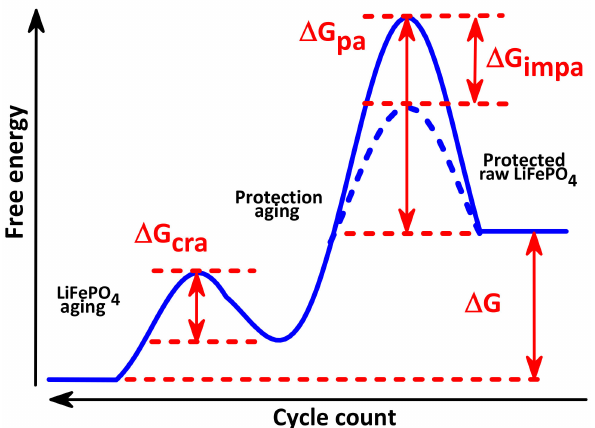
Figure 6. Scheme of two-stage LiFePO 4 cathode degradation. Here, the free energy in the metastable state is ∆ G at the battery operating temperatures. With an increased number of cycles, the protective ferric-graphite-graphene layer is destroyed with the corrosion activation energy ∆ G pa ; a decrease in this activation energy by ∆ G impa occurs in the presence of impurities that catalyze the corrosion processes. The second stage is degradation with activation energy of ∆ G cra of unprotected crystallite destruction into an amorphous